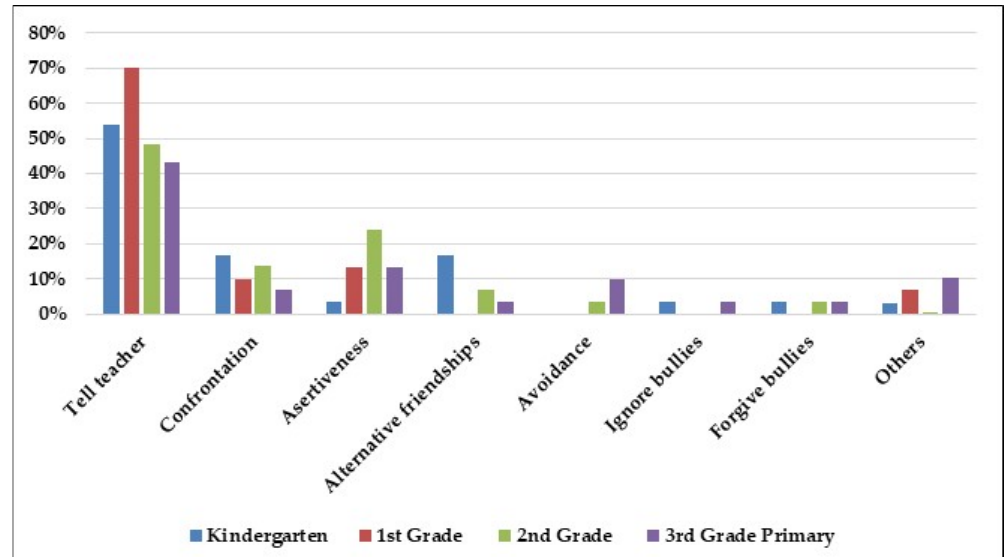
Figure 8. Coping strategies per grade.